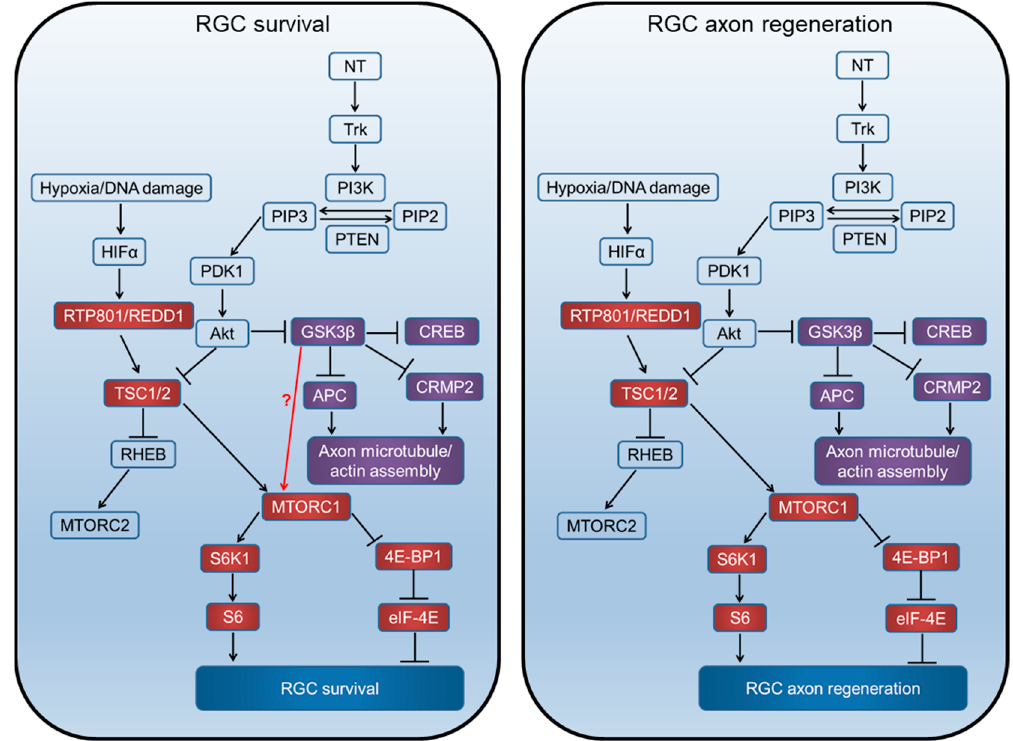
Figure 10. Proposed mechanism of RGC survival and axon regeneration by GSK3 β and RTP801. RGC survival is signalled through the mTORC1 pathway downstream of GSK3 β , whilst axon regeneration is signalled independently by mTOR and GSK3 β pathways. The question mark and the red arrow represent unknown effectors downstream of GSK3 β .